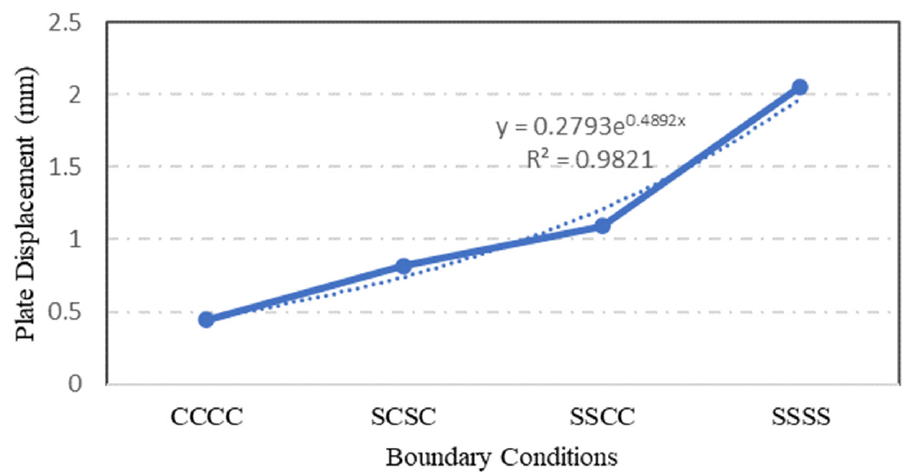
Figure 25. Variation in maximum displacement with different boundary conditions.